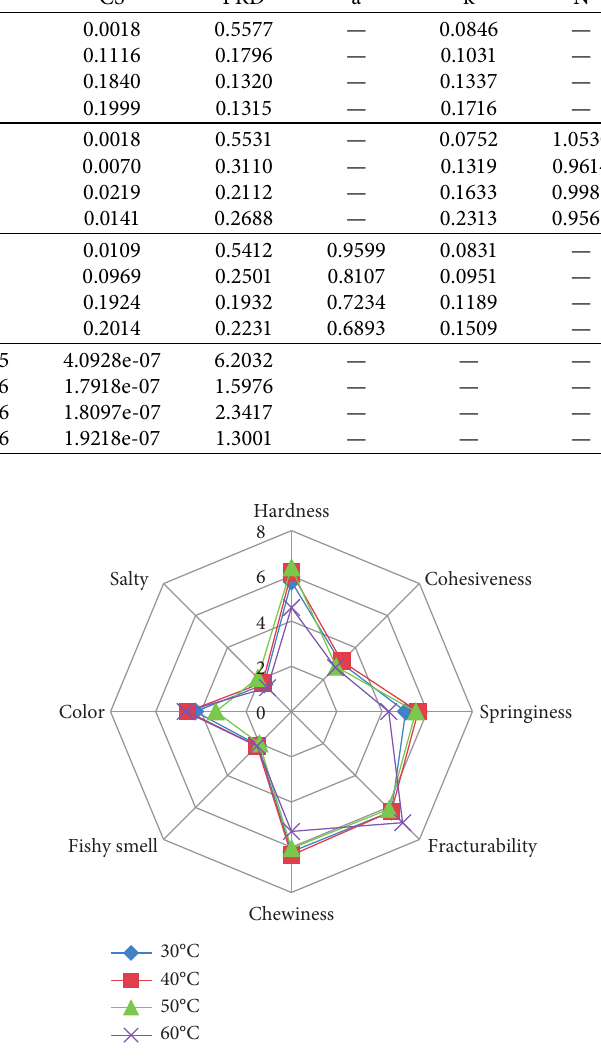
Table 3: The estimated values of statistical parameters and model at different drying conditions. Equation/model